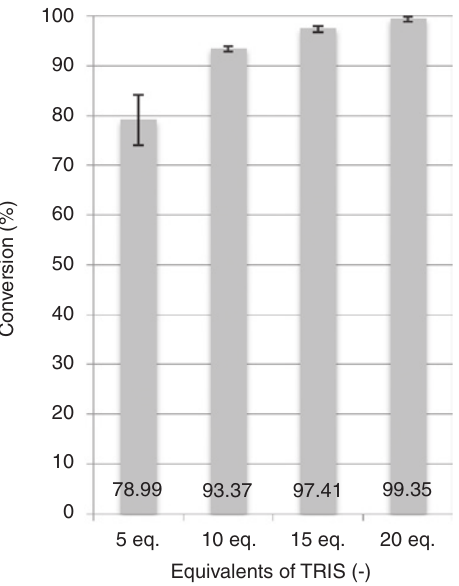
Figure 3: Removal of benzaldehyde from the water/ethanol solvent mixture when 0.06 M solution of the aldehyde was treated with different amounts of tris(hydroxymethyl)aminomethane (TRIS) and after just 1 h of the reaction time for a temperature of 50 ° C.